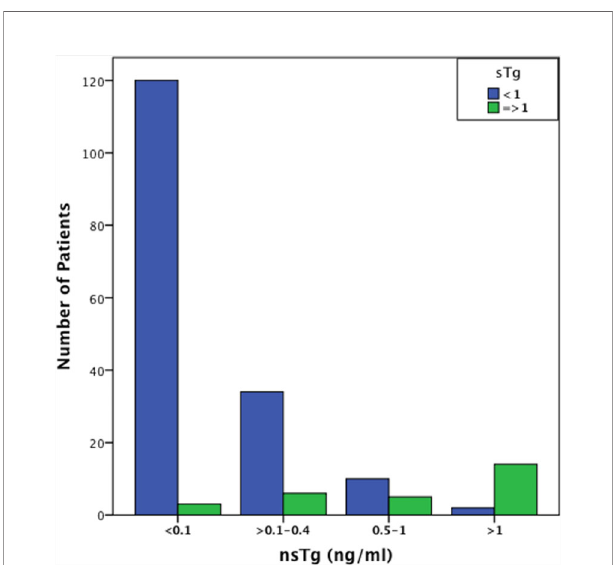
FIGURE 1 | Graphical representation of the number of patients with sTg values < and >1 ng/ml in the different nsTg strati fi cation groups. The graph demonstrate that most patients with low, undetectable nsTg <0.1 ng/ml also have low sTg levels. It also shows that an increase in the nsTg level leads to an increase in the sTg level that is signi fi cantly positively correlated (p <0.001). sTg, stimulated thyroglobulin; nsTg, serum non-stimulated thyroglobulin.